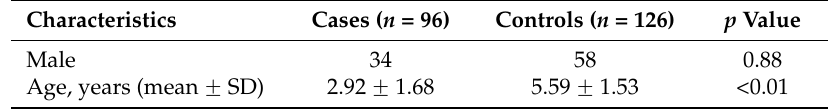
Table 1. Demographic characteristics of the study